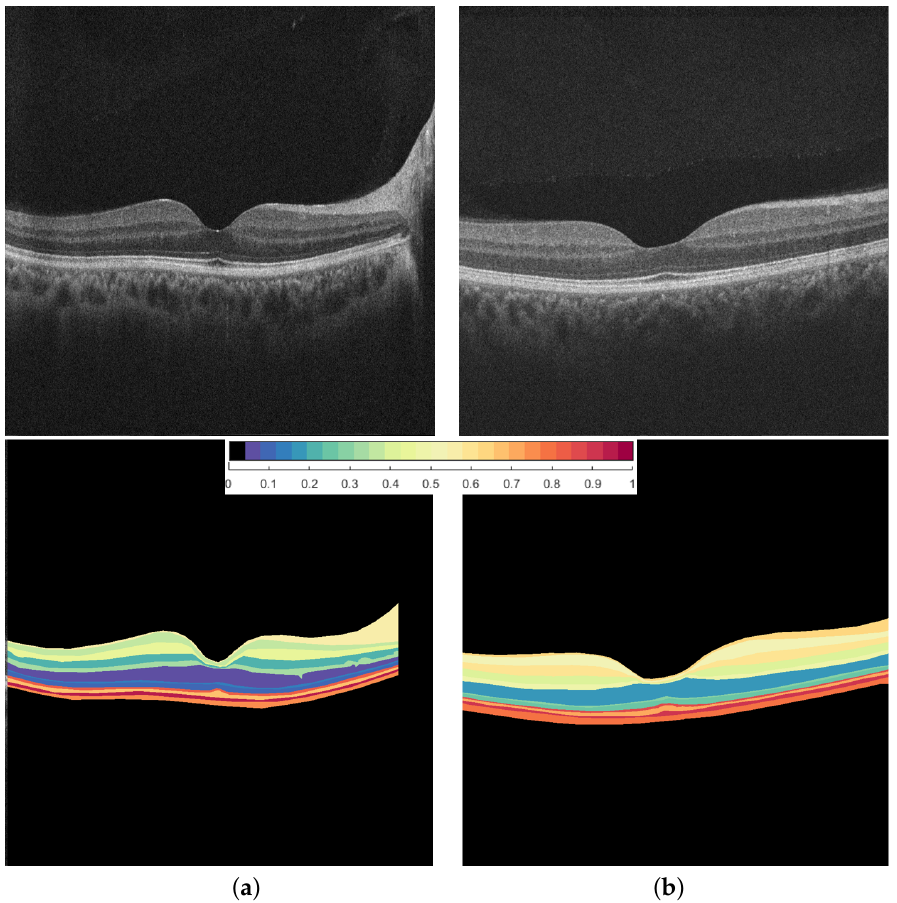
Figure 4. Reflectivity maps for ( a ) a normal subject and ( b ) a DR subject. First row is the original images and second row is the normalized colored reflectivity maps for